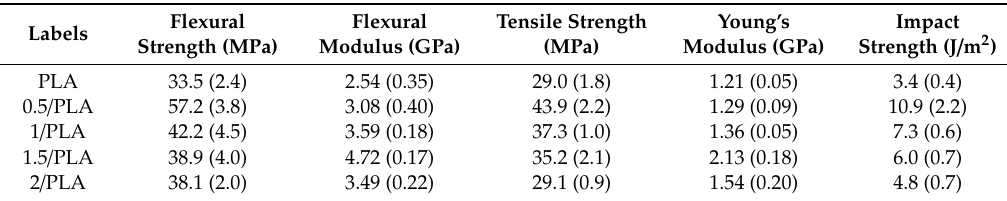
Table 3. Mechanical properties of virgin polylactic acid (PLA) and organo-modified layered montmorillonite (OMMT)—containing PLA [39].